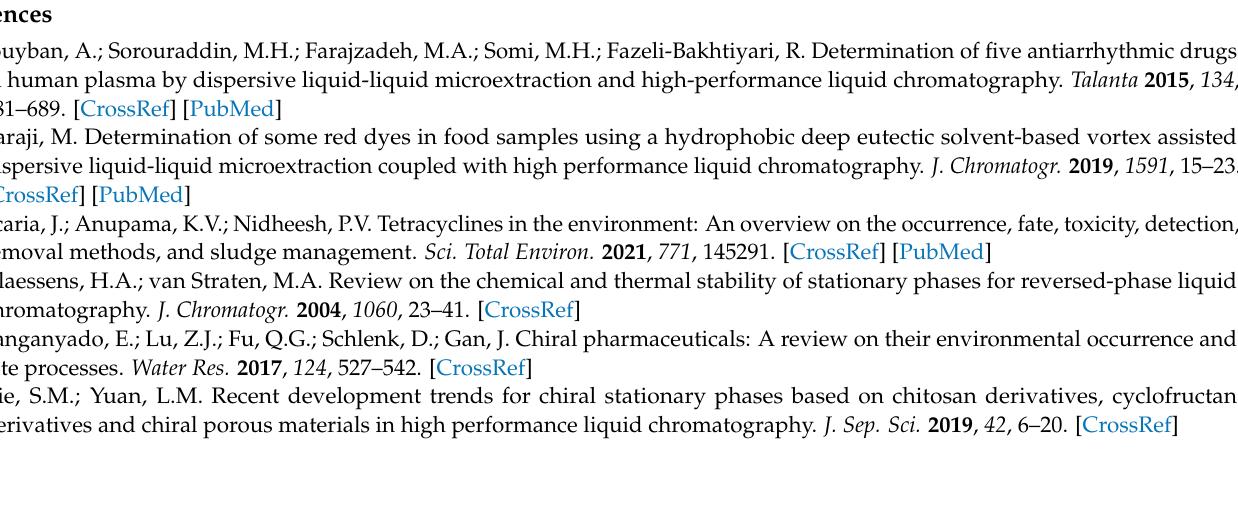
methylene number for different mobile phase compositions; Figure S7: Chromatograms of alkyl phenyl cyclic compounds on the RCC3-C10@silica molecular cage column and WondaSil ® C18-WR column; Figure S8: Plot of log k versus volume fraction of methanol and acetonitrile in mobile phase; Figure S9: Chromatograms of PAHs on the RCC3-C10@silica molecular cage column and WondaSil ® C18-WR column; Figure S10: Chromatograms of PAHs on the RCC3-C10@silica molecular cage column and WondaSil ® C18-WR column; Figure S11: Chromatograms of phenol compounds on the RCC3-C10@silica column and WondaSil ® C18-WR column; Figure S12: Chromatogram of nucleoside on the RCC3-C10@silica column and WondaSil ® C18-WR column; Figure S13: Chromatogram of sulfonamides on the RCC3-C10@silica column and WondaSil ® C18-WR column; Figure S14: Chromatogram of flavanones on the RCC3-C10@silica column and WondaSil ® C18-WR column; Figure S15: Repeatability of six compounds on RCC3-C10@silica column; Table S1: Retention factors and selection factors of Tanaka test analytes on RCC3-C10@silica column and WondaSil ® C18-WR column; Table S2: Retention factors and selection factors of PAHs on the RCC3-C10@silica molecular cage column and WondaSil ® C18-WR column; Table S3: Retention factors and selection factors of polar aromatic analytes on the RCC3-C10@silica column and WondaSil ® C18-WR